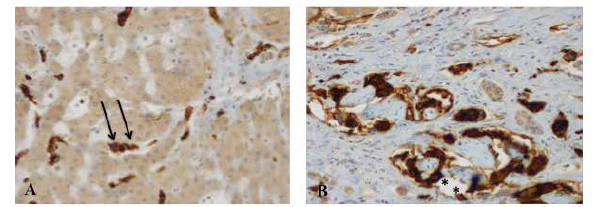
Figure 2: Immunoistochemical findings using ABC/HRP method. A strong immunostaining for CD34 was observed. Neoplastic cells expressed CD34 in sinusoids (arrows) (A) and in the lumen of stromal vessels (asterisks) (B).Original magnification x